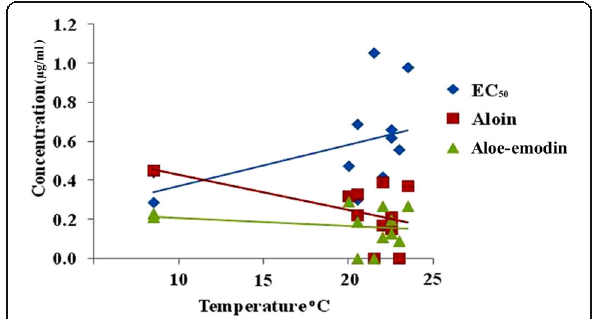
Fig. 4 Correlation analysis of temperature with aloin and aloe-emodin quantities and antiplasmodial EC 50 values of different Aloe vera